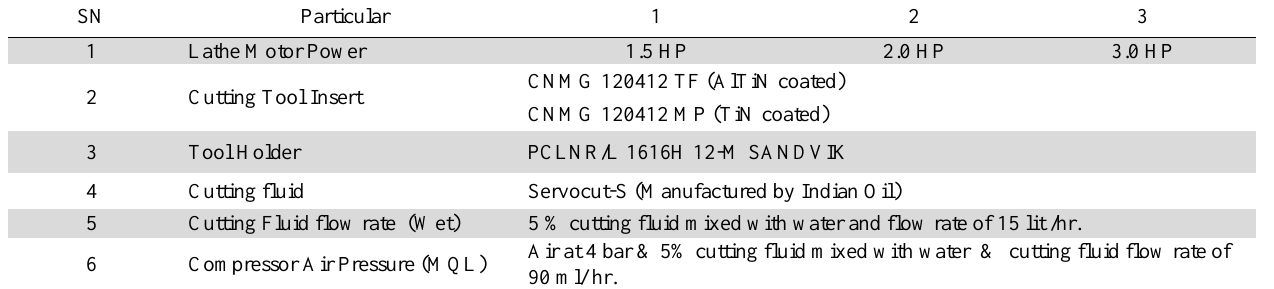
Details of the machine, tool , tool holder and cutting fluid